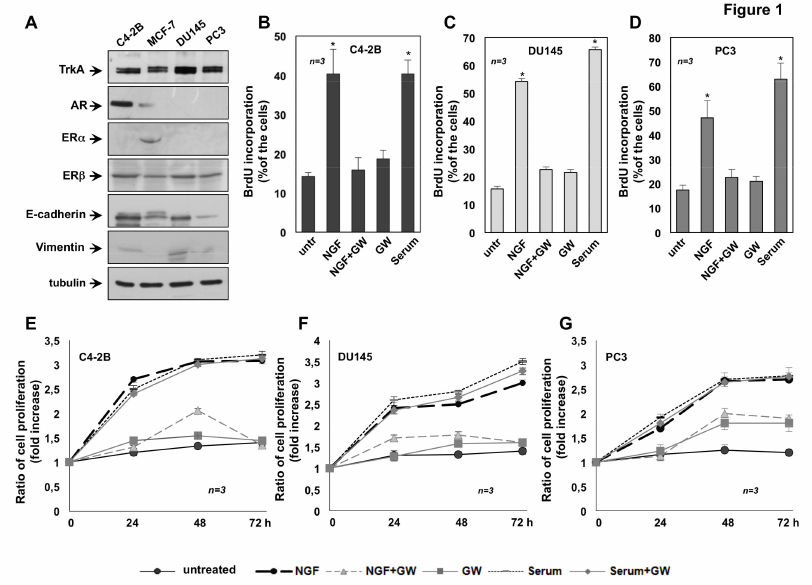
Figure 1. Tropomyosin receptor kinase A (TrkA) activation mediates the nerve growth factor (NGF) mitogenic e ff ect in castration-resistant prostate cancer (CRPC) cells. C4-2B, DU145 and PC3 cells were used. In A , lysates from the indicated cell lines were prepared and proteins were analyzed by Western blot, using the antibodies against the indicated proteins. Quiescent C4-2B ( B ), DU145 ( C ) and PC3 ( D ) cells were left untreated (untr) or treated for 18h with the indicated compounds. After in vivo pulse with 100 µ M BrdU, BrdU incorporation was analyzed by IF and expressed as % of total cells. Quiescent C4-2B, DU145 and PC3 cells were left untreated (untr) or treated for 18h with 20% (v / v) serum, in the absence or presence of GW441756. After in vivo pulse with 100 µ M BrdU, BrdU incorporation was analyzed by IF and expressed as % of total cells. Under basal conditions, 9%, 12% and 14% of C4-2B, DU145 and PC3 cells, respectively, incorporated BrdU. Serum stimulation increased by 45%, 67% and 59% the number of BrdU incorporating C4-2B, DU145 and PC3 cells, respectively. Addition of GW441756 did not significantly inhibit this number (43%, 63% and 57% for C4-2B, DU145 and PC3 cells, respectively). Quiescent C4-2B ( E ), DU145 ( F ) and PC3 ( G ) were left untreated or treated for 24, 48 and 72 h with the indicated compounds. Cell proliferation was assayed using the WST-1 (water soluble tetrazolium-1) reagent. Graphs in E – G represent the ratio of proliferation, which was expressed as fold increase over the basal absorbance. NGF stimulation induced a significant variation of the proliferation as compared with untreated cells ( p < 0.05). In B – G , NGF was used at 100 ng / mL; GW441756 (GW) was used at 1 µ M. When indicated, serum was used at 20% (v / v). Three independent experiments were done. Means and standard error of the means (SEMs) are shown. n represents the number of experiments. * p < 0.05 for the indicated experimental points vs. the corresponding untreated